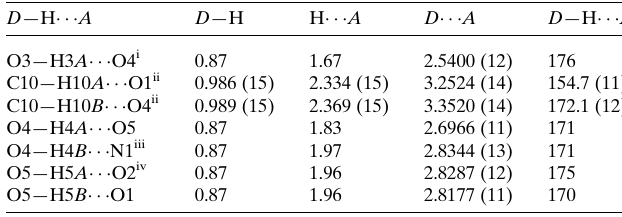
Table 1 Hydrogen-bond geometry (A˚ , (cid:4) ).